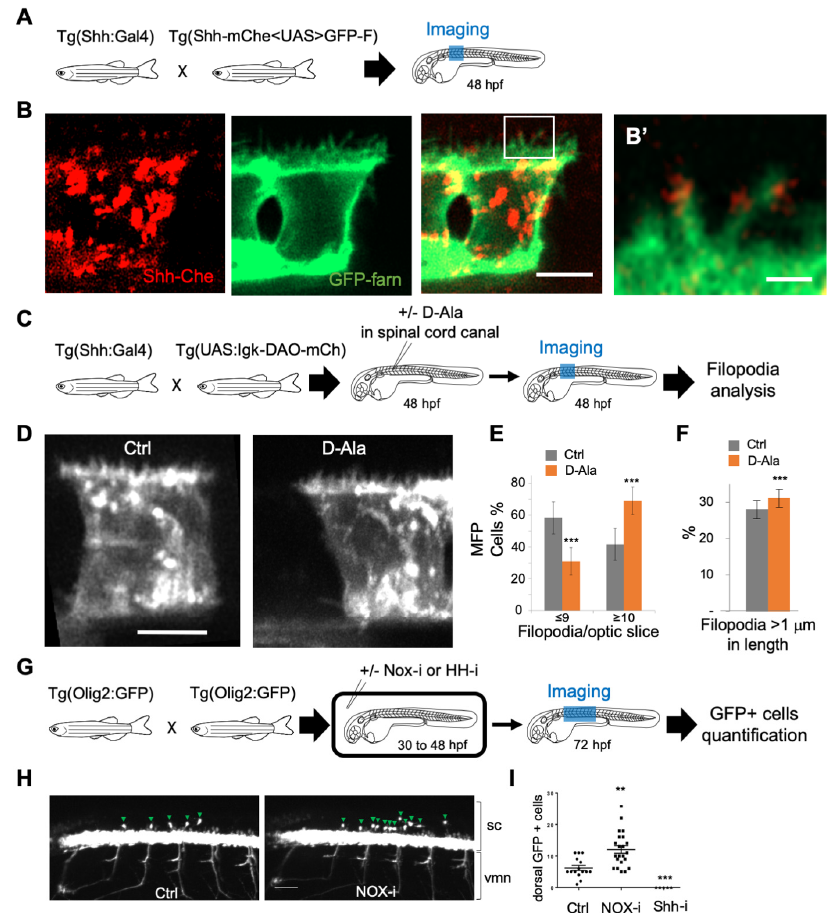
Figure 5. H 2 O 2 modulates filopodia production and OPC behavior in the zebrafish spinal cord. ( A , C , G ) Experimental procedures for the results shown in B–B’ ( A ), D–F ( C ) and H–I ( G ). ( B ) Shh- mCherry visualization in MFP filopodia in live embryos at 48 hpf (Scale bar: 5 μ m). ( B’ ) Enlarged view (scale bar: 1 μ m). ( D ) Visualization of filopodia at 48 hpf in Tg(2.4Shha-ABC:Gal4-FF;UAS:Igk- mb5-DAO-mCherry) before or after D-Ala (10 mM) injection in spinal cord canal (scale bar: 5 μ m). ( E ) Quantification of filopodia in MFP cells (see Methods) in Ctrl and D-Ala-injected larvae. ( F ) Pro- portion of filopodia longer than 1 μ m in MFPs of Ctrl and D-Ala-injected larvae. ( H ) Detection of GFP at 72 hpf in Tg(olig2:EGFP) larvae incubated from 30 to 48 hpf in control solution or in NOX-i at 10 μ M. ( I ) Quantification of OPCs generated at 72 hpf after NADPH oxidase inhibitor (Nox-i) or cyclopamine (shh-i) treatments. ** p -value ≤ 0.01 and *** p -value ≤ 0.001. Details on statistics in Meth- ods. sc: spinal cord; vmn: ventral motor nerves.